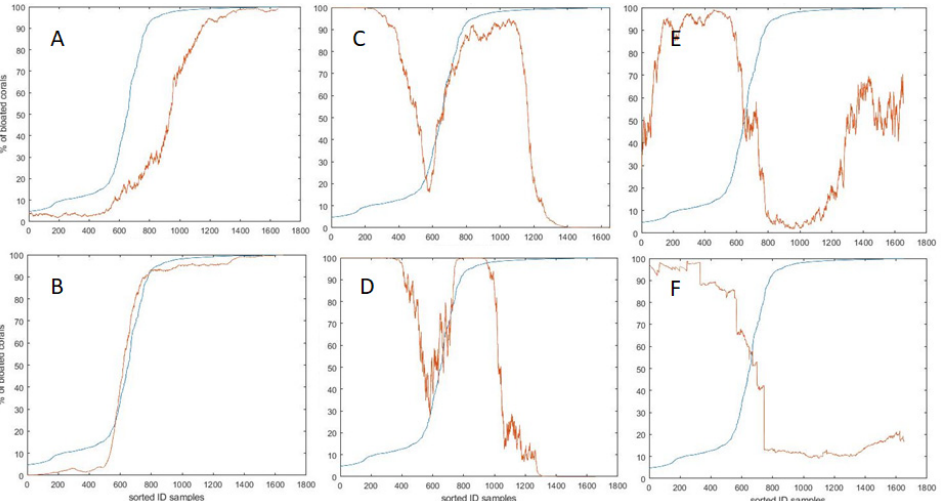
Figure 14. Samples sorted by increasing percentage of bloated coral status (saturation blue lines curves). The sigmoidal function of the centered and standardized oceanographic variables (red lines) are: ( A ) time of the day, ( B ) chlorophyll, ( C ) salinity, ( D ) temperature, ( E ) depth, and ( F ) turbidity. Before processing the oceanographic standardized variables with the sigmoidal function, a moving average was applied in order to smooth their signal.